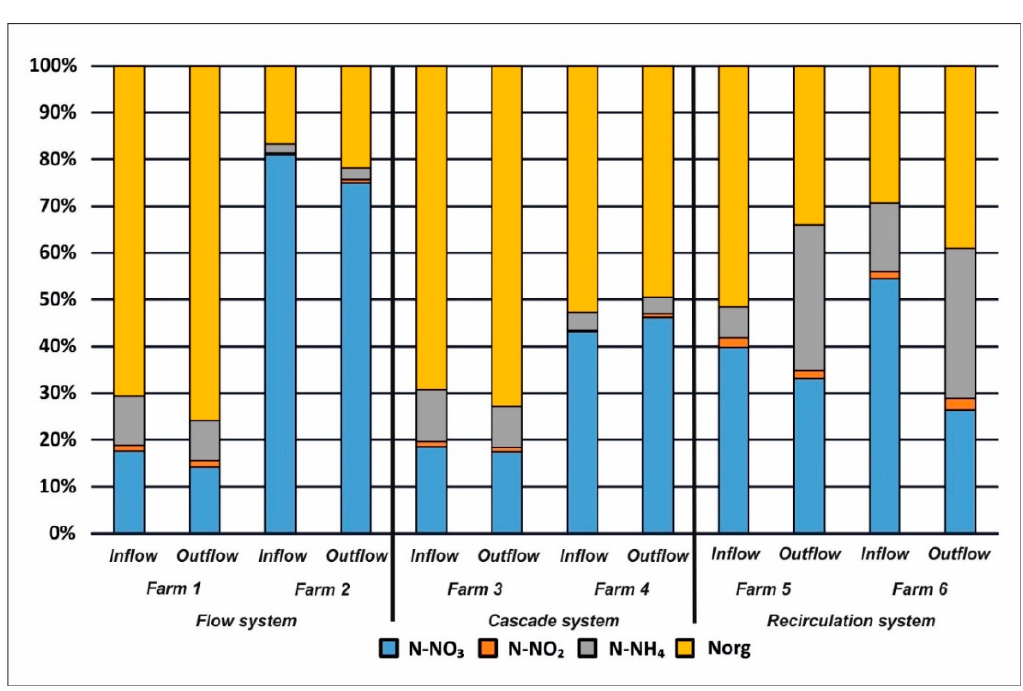
Figure 3. Contribution of particular forms of nitrogen in waters used in rainbow trout culture (%).